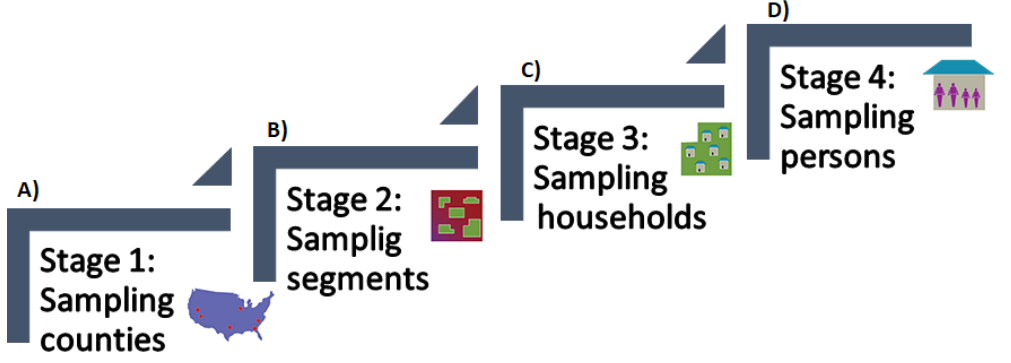
Figure 2. Flowchart of the stages followed by NHANES 2013–2014 for the sampling of